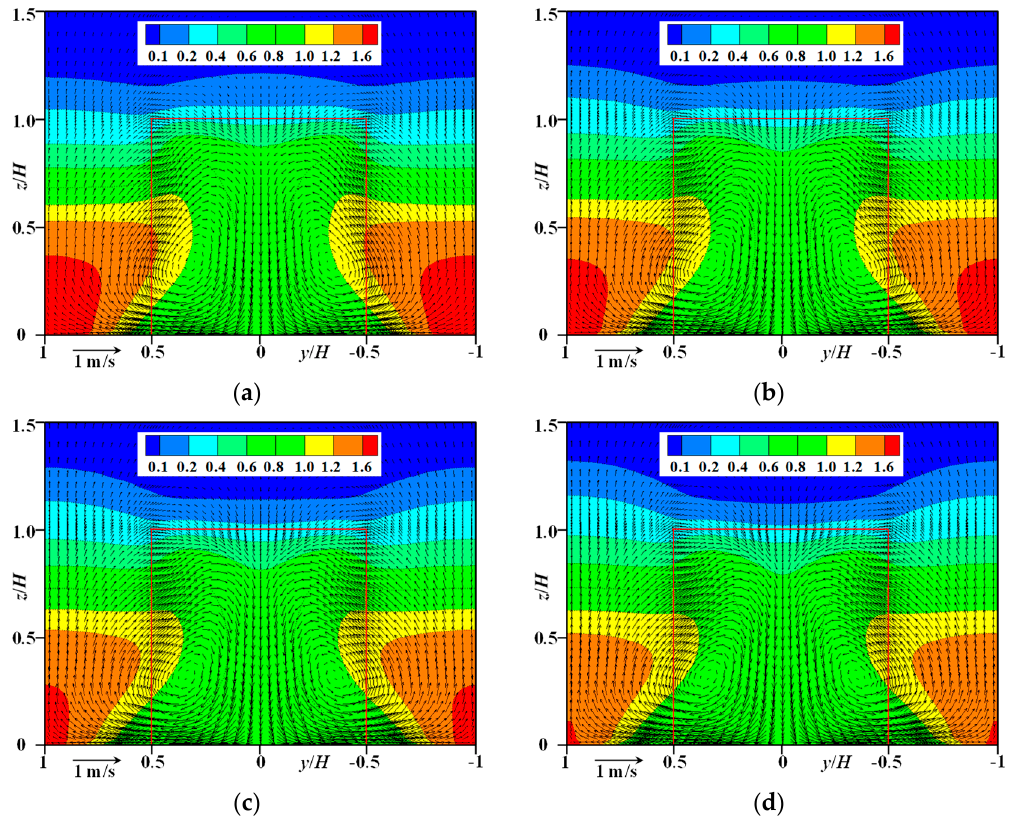
Figure 11. Mean velocity vectors and normalized concentration C / C * in middle cross section of the TSC ( x / H = 0): ( a ) GH-30; ( b ) GH-40; ( c ) GH-50; ( d ) GH-60.